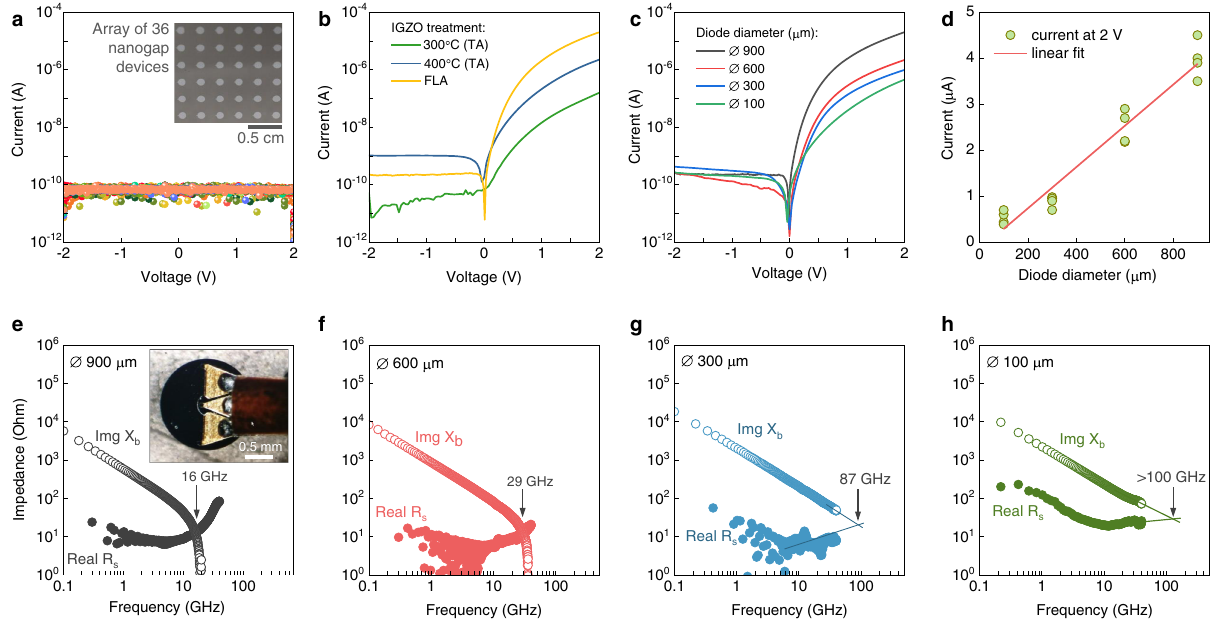
Fig. 3 Electrical and S-parameters (S 11 ) measurements. a I – V characteristics of one complete array of 36 devices consisting of empty Al/Ti-Pt nanogap electrodes (inset photograph). The consistent current level below 0.1 nA implies complete electrical insulation between both metals. b I – V characteristics of thermally annealed and Flash Lamp Annealed (FLA) Al/IGZO/Ti-Pt diodes. The FLA processed diodes show better recti fi cation, less hysteresis, and a turn-on closer to 0 V compared to the thermally annealed diodes. c I – V characteristics of FLA diodes where the current is scaling up with the diode ’ s diameter. d The current at 2 V for several diodes, which is scaling with diode ’ s diameter. The linear fi t to the experimental data (R 2 = 0.997) validates